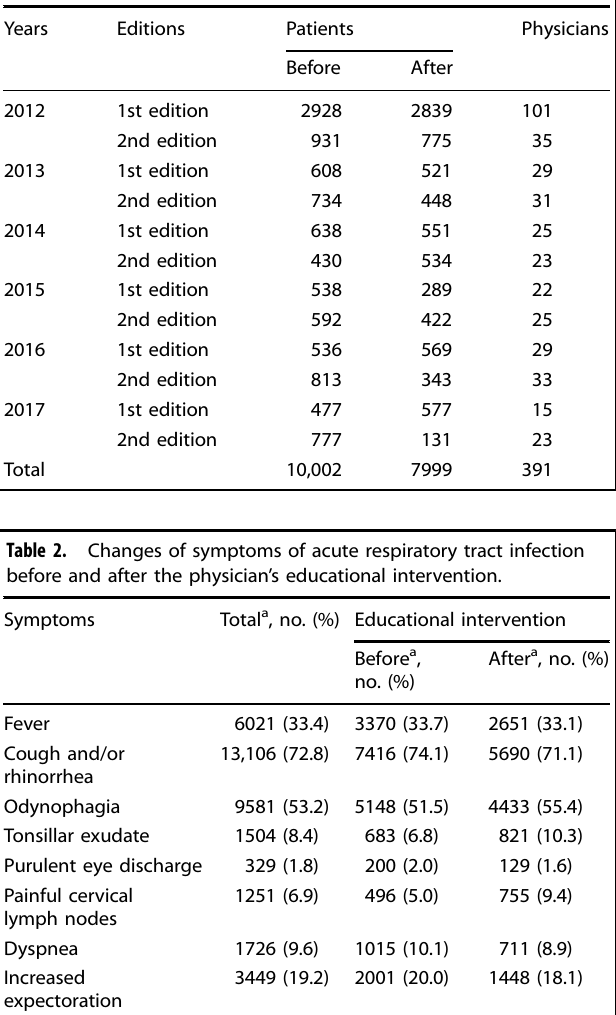
Table 1. Number of physicians and patients included in each edition of the study.